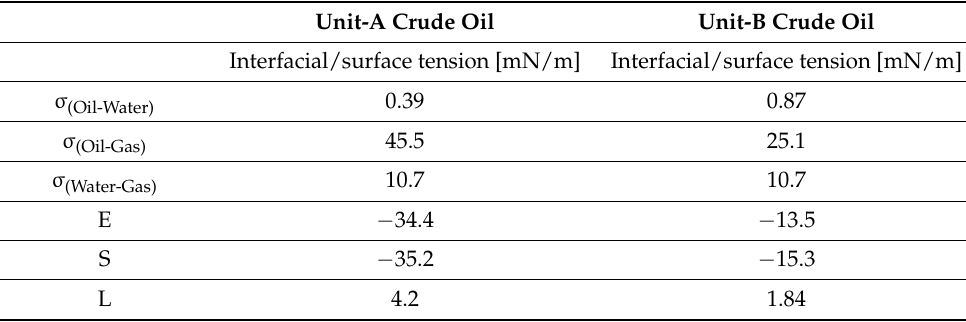
Table 4. Interfacial tension measurements and oil-foam interaction parameters.